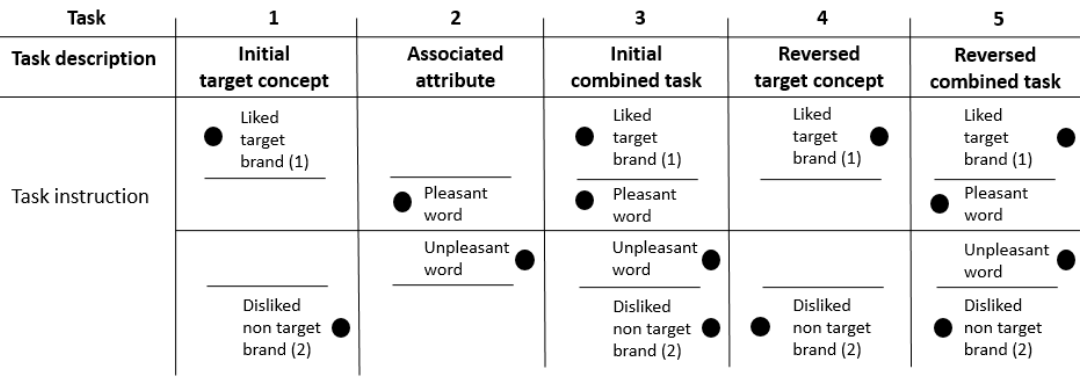
Figure 1. Modified version of the original IAT (adapted from Greenwald et al. [33]. Filled black circles on the left or right of the stimulus correspond to left and right (respectively) button presses. Task 3 = congruent, Task 5 = Incongruent condition. Participants completed this task during each of the lab sessions, once for a liked brand and once for a disliked